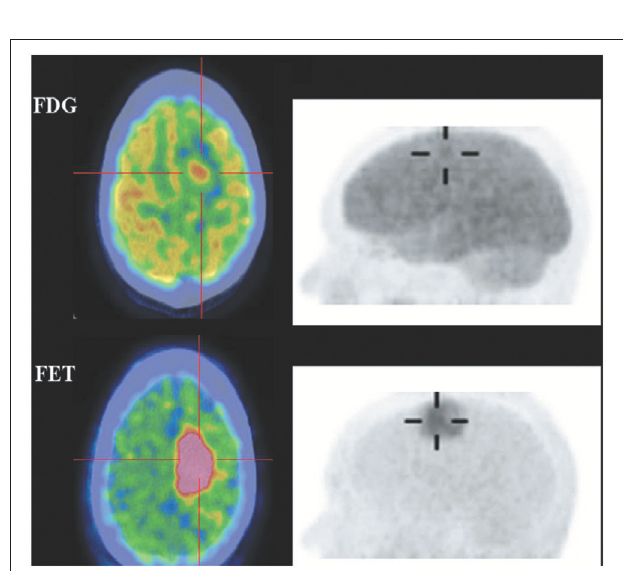
FIGURE 4 | Images of a patient with recurrent glioma of World Health Organization (WHO) grade II oligodendrocytoma histologyon the background of WHO grade III anaplastic astrocytoma on initial diagnosis. Axial 18 F-FDG (top), 18 F-FET (bottom) fused PET/CT (left) and lateral maximum intensity projection images (right). 18 F-FET imaging illustrated that the recurrent tumor in the right frontal lobe (cross-hairs) was better visualized and defined, and had a much lower brain uptake background to allow a good tumor-background contrast. This figure is reproduced with permission from Lau et al. (2010), Figure 4 © by the Society of Journal of Clinical Neuroscience,